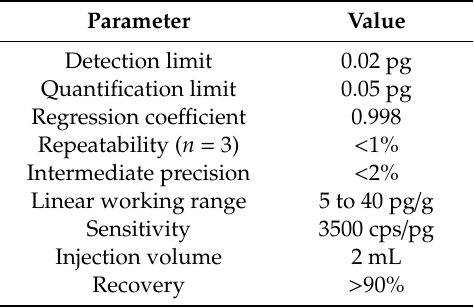
Table 1. Main analytical parameters of the SeaFAST system with ICP-DRC-MS